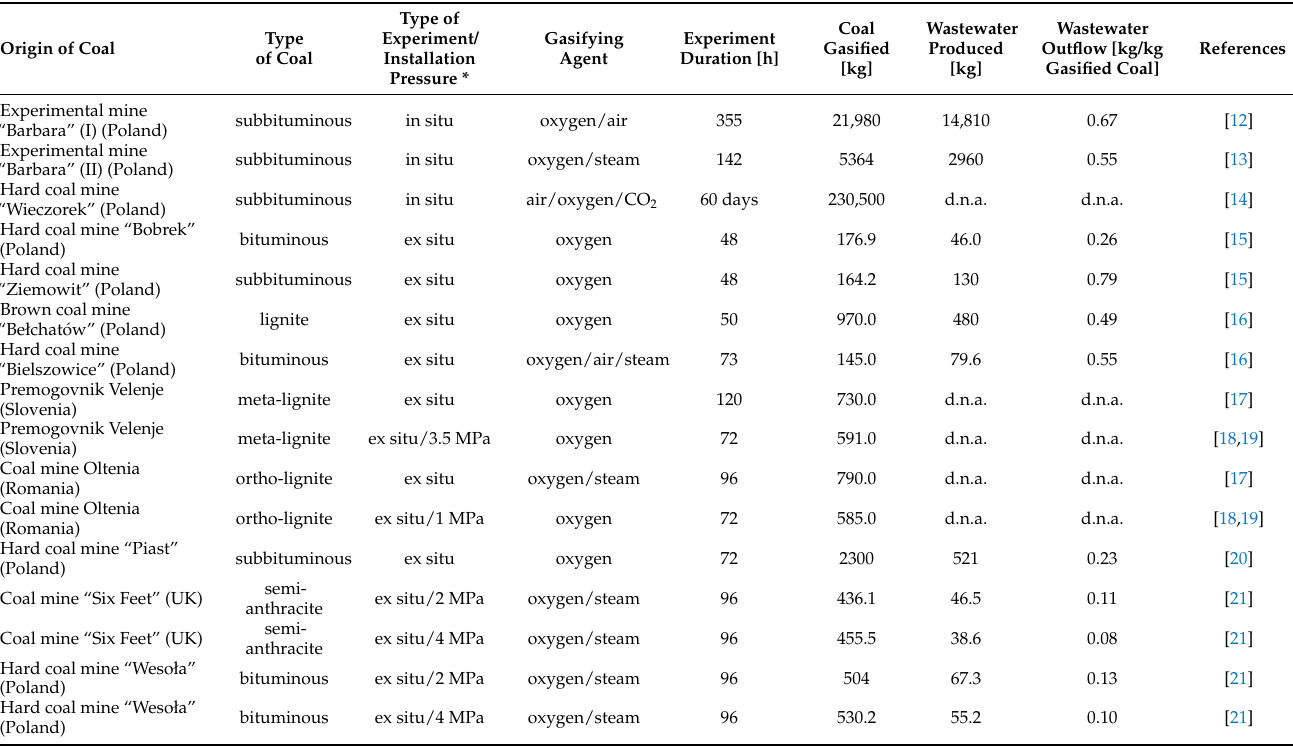
Table 3. General characteristics of the main UCG in situ and ex situ experiments conducted by the Central Mining Institute in years